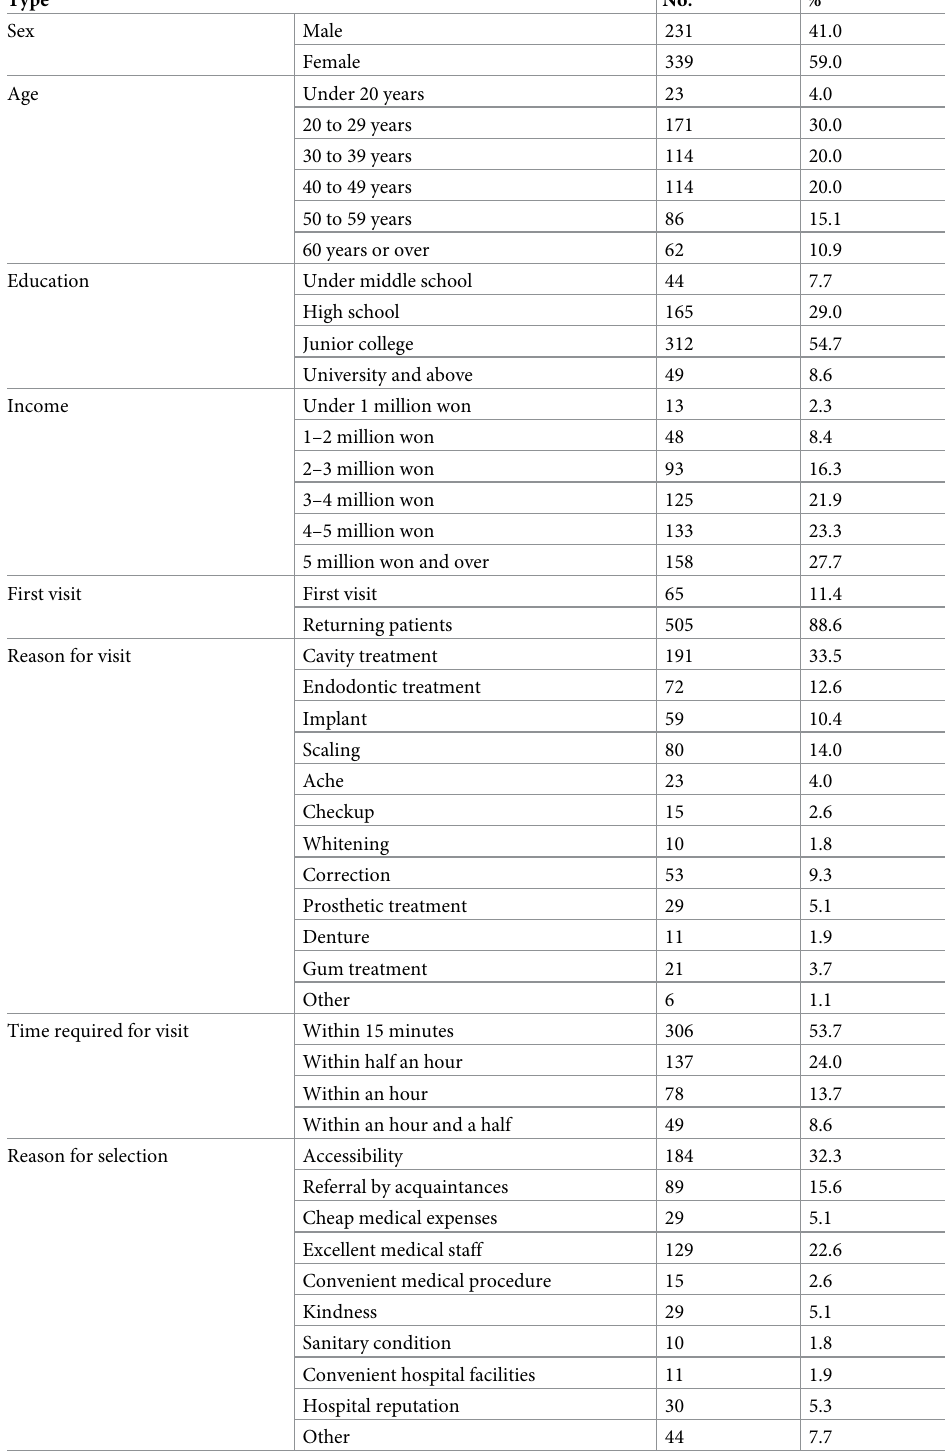
Table 1. Participants’ demographic characteristics and medical utilization